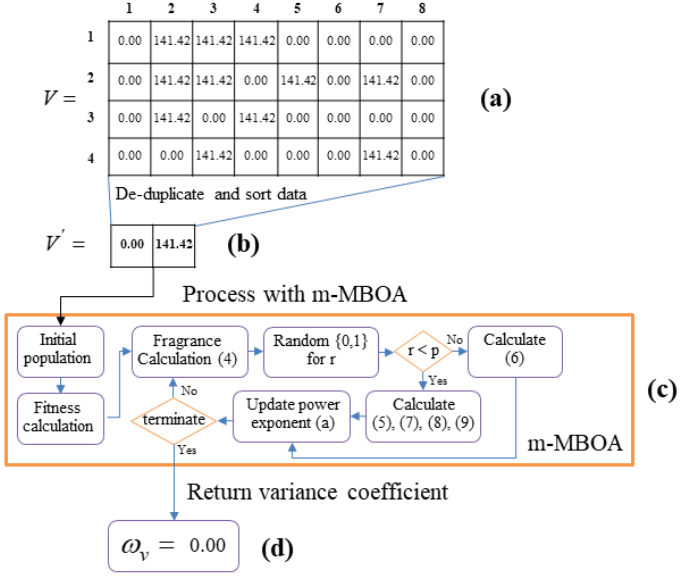
Figure 5. The m-MBOA process. ( a ) Variance decision table; ( b ) Create vector V’ by de- duplicate and sort data; ( c ) process m-MBOA algorithm to create the variation coefficient; and ( d ) variation